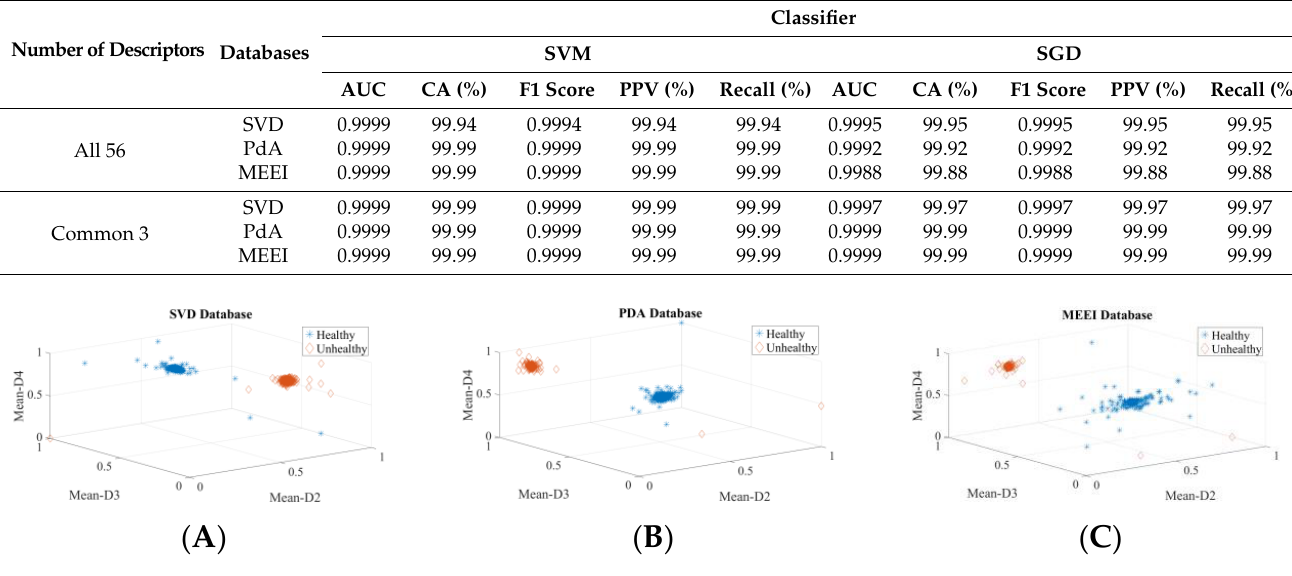
Table 10. Classifier performance measures for voice pathology identification for SVD, PdA, and MEEI.